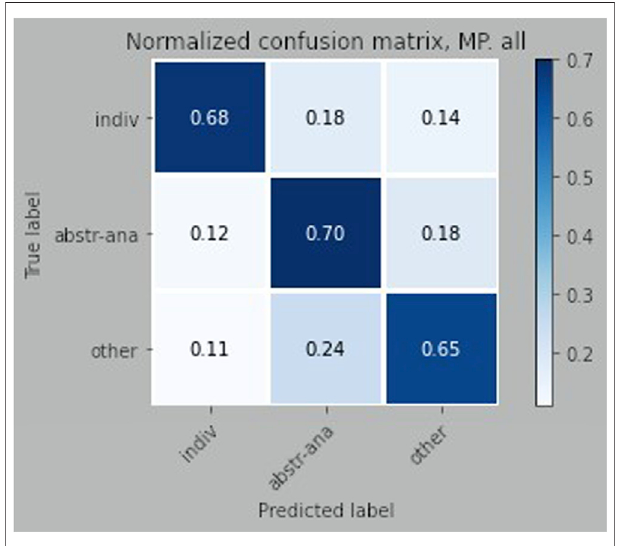
FIGURE 1 | Normalized confusion matrix for the DanPASS dialogues.